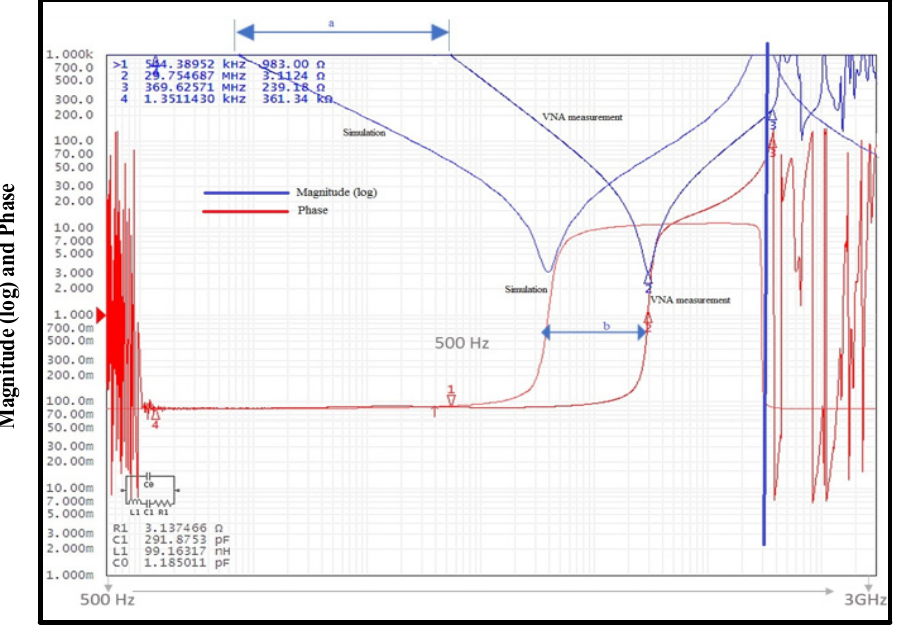
Figure 11. Impedance response for the terminals of Transphorm device.